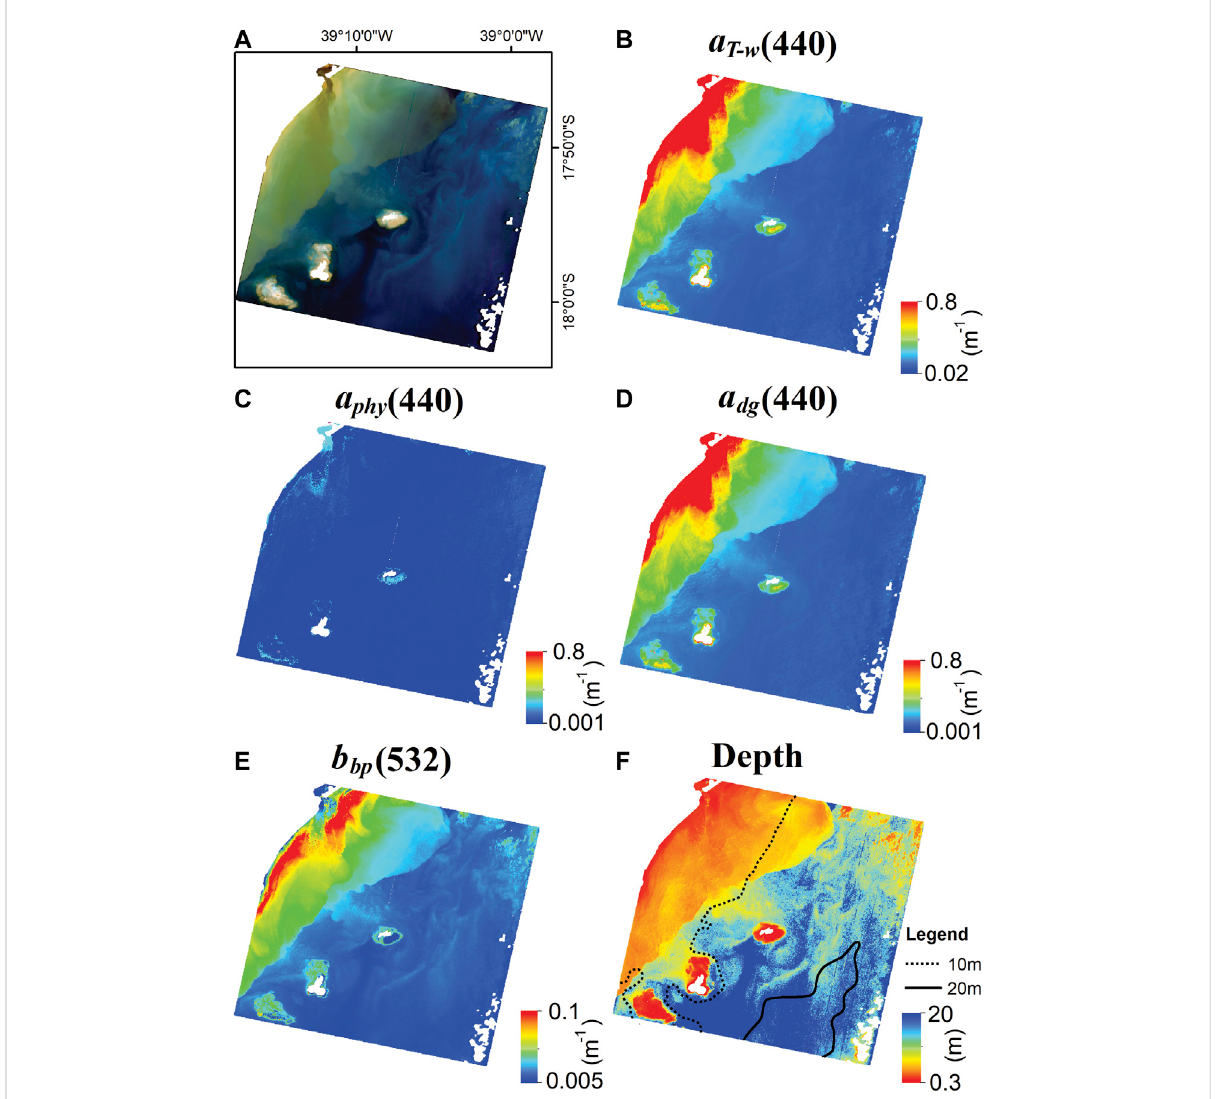
FIGURE 8 OpticalpropertiesanddepthretrievalsinABRfromPRISMAimageusingHOPEmodelwithalinearmixtureassubstrateinput. (A)